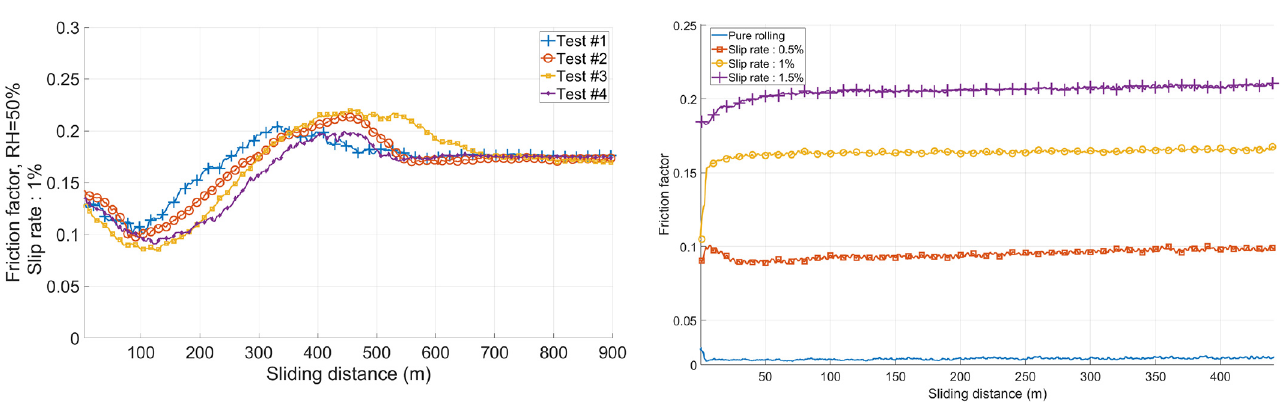
Fig. 11. Reference values of the friction factor obtained with- out introduction of third body in the contact on the Triboring tribometer at different slip